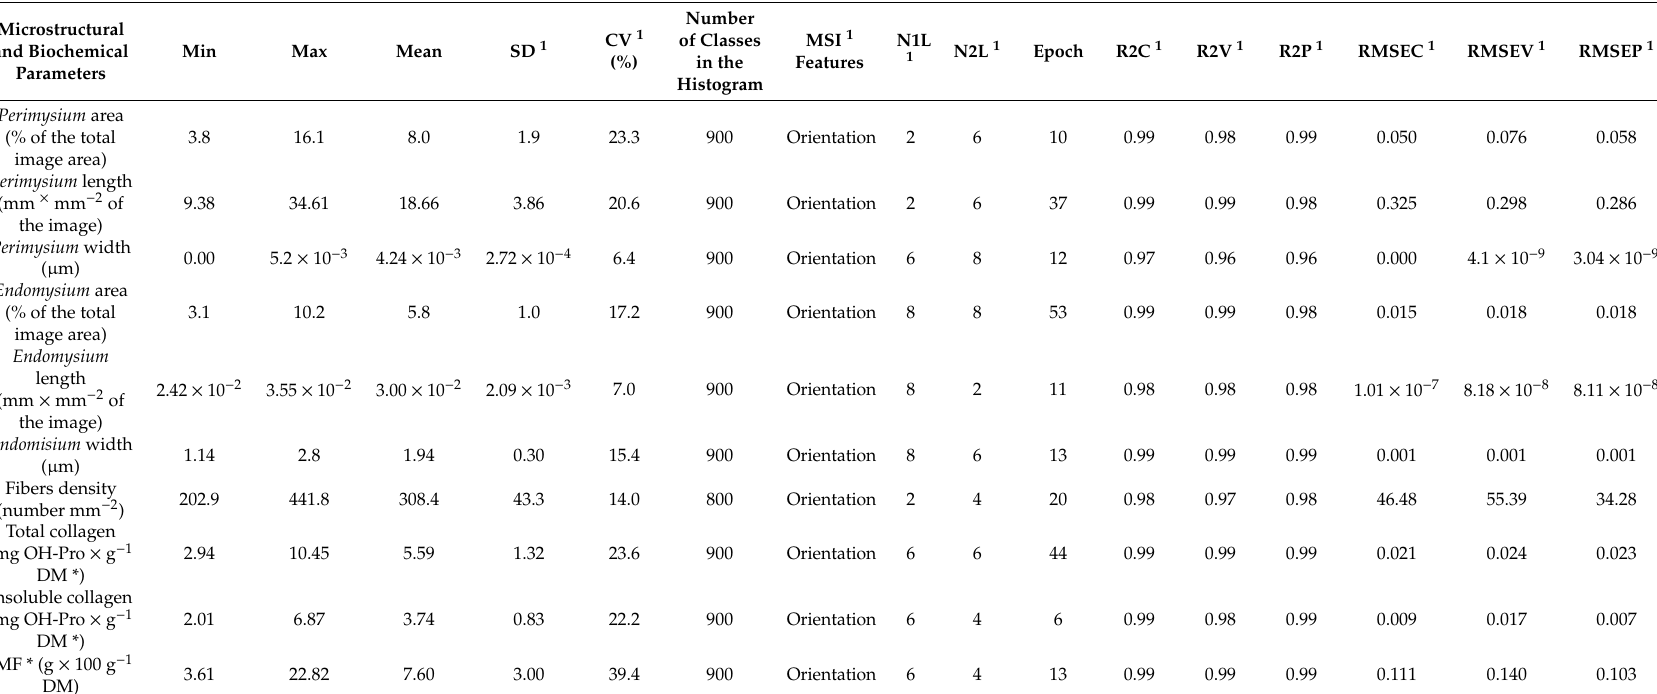
Table 1. The best artificial neural network (ANN) results obtained for structural parameters of intramuscular connective tissue and biochemical features of the beef